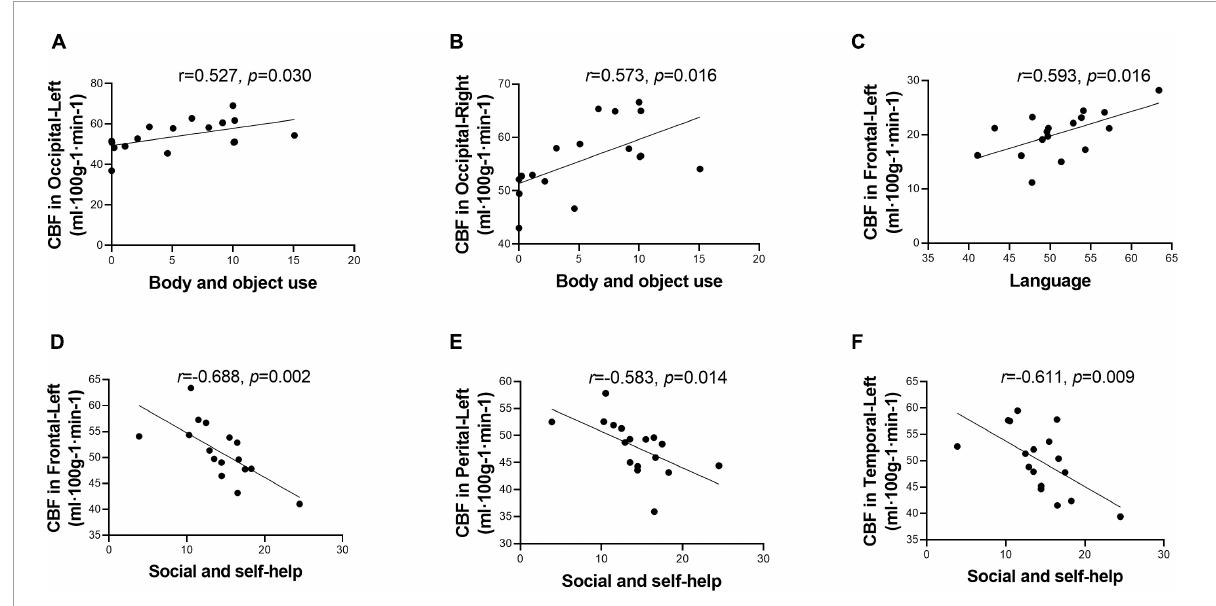
FIGURE3 Score of Autism Behavior Checklist (ABC) domains correlated with cerebral blood flow (CBF) in different regions. Score of body and object use was positively correlated with CBF in the bilateral occipital lobes (A,B) . Score of language was positively correlated with CBF in the left frontal lobe (C) . Score of social and self-help was negatively correlated with CBF in the left hemisphere, including frontal lobe, perietal lobe, and temporal lobe (D–F) . While after multiple comparisons correction, the correlation was not statistically